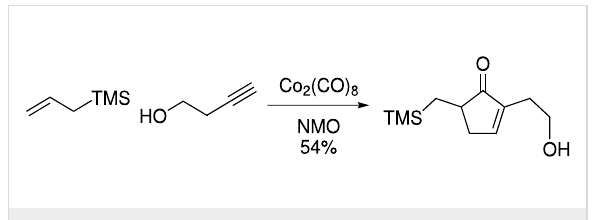
Scheme 6: Model Pauson-Khand reaction of